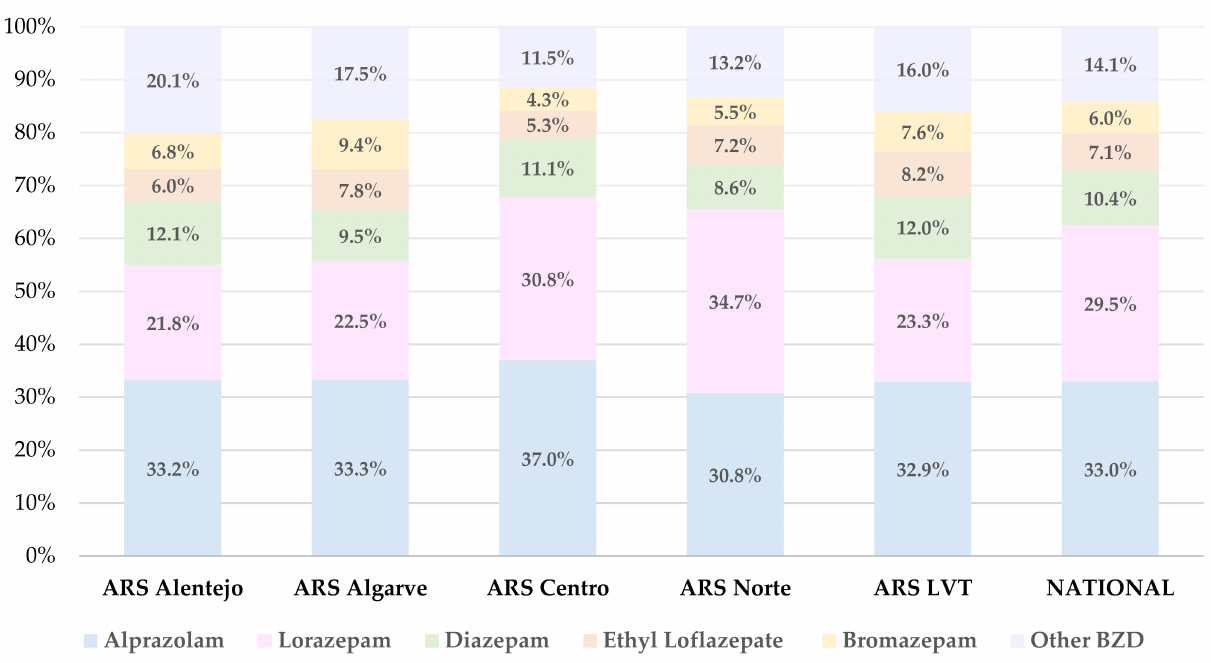
Figure 2. Percentage of alprazolam, diazepam, ethyl loflazepate, bromazepam, lorazepam, and other BZD, giving the total number of prescribed BZD, according to each ARS and at a national level, between 2019 and